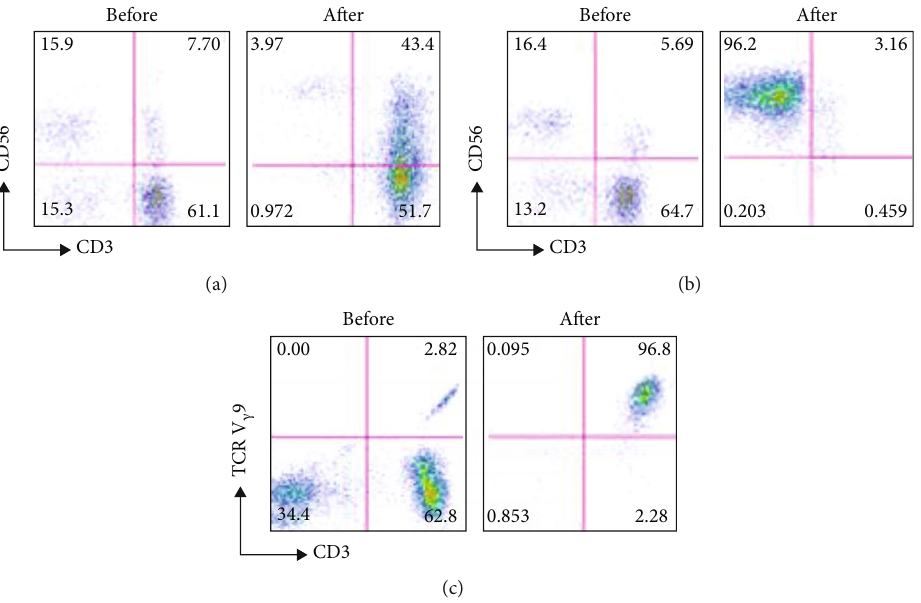
Figure 2: (a) The percentage of CIK cells including (CD3 + CD56 + ), (CD3 + CD56 − ), and (CD3 − CD56 + ) before and after induction and CD4 + and CD8 + before and after induction in one of the patients. (b) The percentage of NK cells (CD3 + CD56 − ) before and after induction and the activated NK (CD56 + CD69 + ) before and after induction in one of the patients. (c) The percentage of γδ T before and after induction in one of the